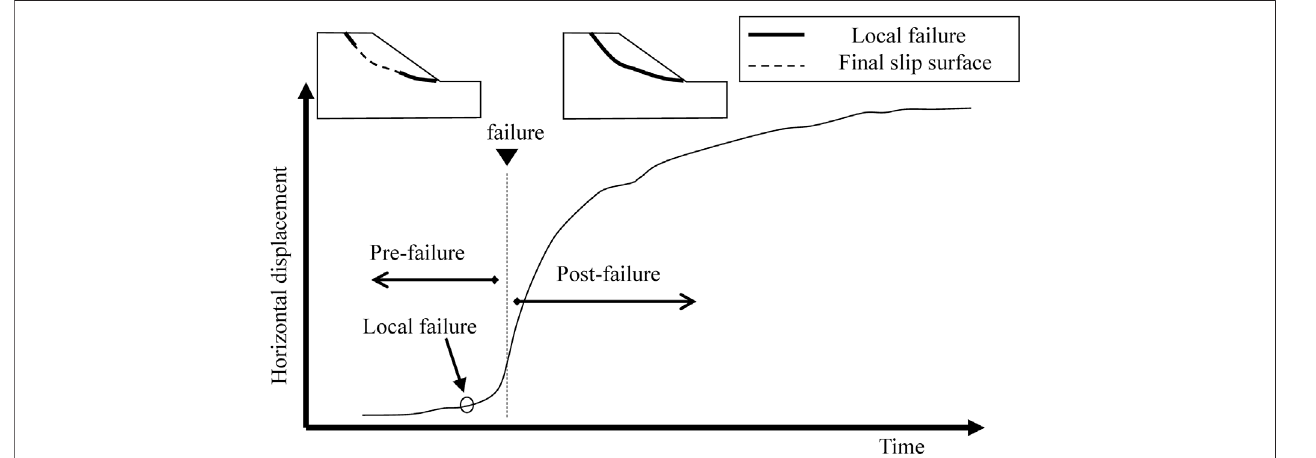
FIGURE 1 | Schematic of slope behavior (modi fi ed from Picarelli et al., 2004).